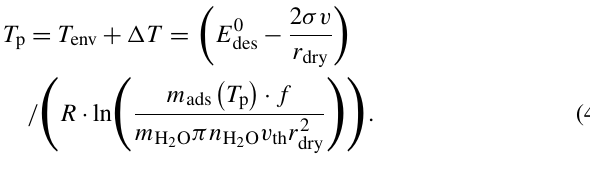
= 1 . 1 × 10 16 m − 3 ). 2 O